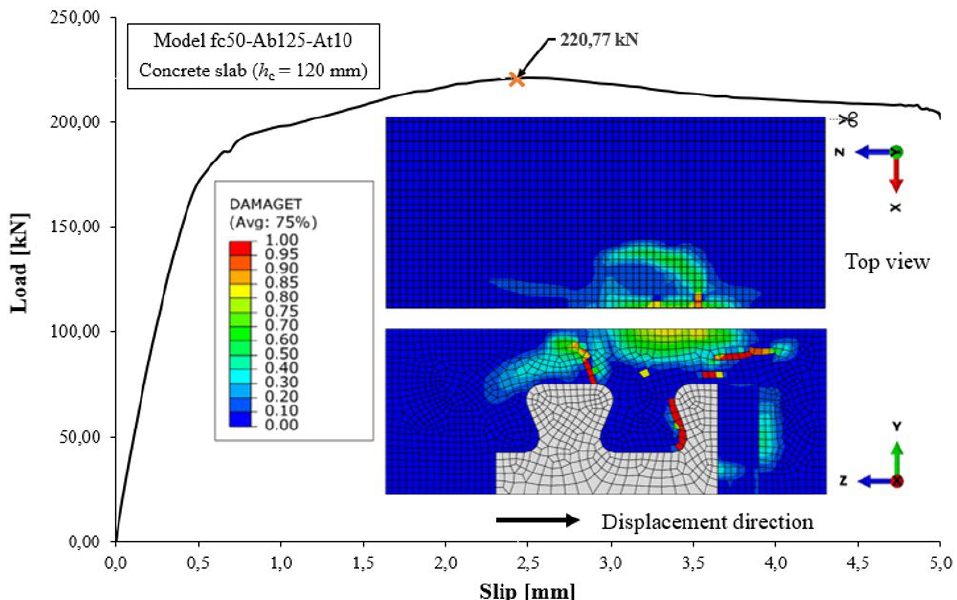
Figure 22. Load-slip curve of 'fc50-Ab125-At10' model ( h c = 120